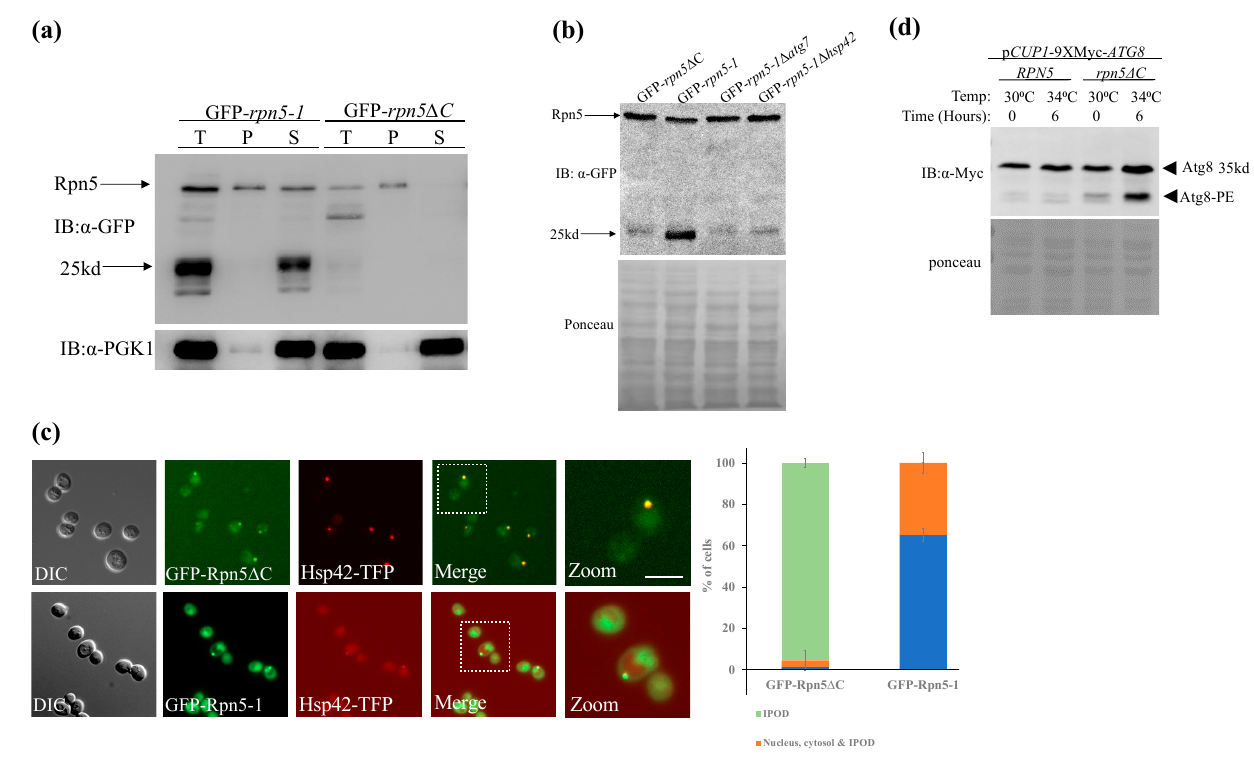
Figure 3. Dysfunctional insoluble proteasomes that accumulate in the IPOD represent an alternative pathway for proteasomes that escape proteaphagy. ( a , b ) Cells carrying the ts alleles of rpn5 Δ C, and rpn5 ‐ 1, expressed under a galactose ‐ inducible promoter ( GAL1 p) (GFP ‐ rpn5 Δ C and GFP ‐ rpn5 ‐ 1, re ‐ spectively) were grown in 2% galactose ‐ containing medium to logarithmic phase at the semi ‐ per ‐ missive temperature (34 °C), and subjected to the detergent solubility assay. ( b ) Free ‐ GFP signal of rpn5 ‐ 1 overexpressed under a GAL1 promoter (GFP ‐ rpn5 ‐ 1) is the result of autophagic cleavage. Cells carrying GFP ‐ rpn5 ‐ 1 and deleted in the control autophagic pathway were subjected to free ‐ GFP assay as described in Figure 1. GFP ‐ rpn5 Δ C was used as a negative control. ( c ) Cell described in A were visualized by differential interference contrast (DIC) microscopy. Images were taken with a 63× objective, and represent a single plane chosen from z ‐ series images extending above and below the entire cell. The GFP and mCherry channels were used to visualize the GFP, and TFP fluores ‐ cence, respectively. The distribution of GFP ‐ rpn5 Δ C and GFP ‐ rpn5 ‐ 1 signal was scored as the per ‐ centage of cells showing: (i.) Puncta colocalizing with the IPOD marker Hsp42 ‐ TFP (IPOD), (ii.) nu ‐ cleus, cytosol & IPOD (iii.) nucleus, cytosol. Error bars show the standard deviation between three independent experiments (a minimum of 50 cells in each experiment). Bars ‐ 5 μ m. ( d ) Autophagy is induced in the rpn5 Δ C mutant. Logarithmically growing wt and rpn5 Δ C cells expressing ATG8 N ‐ terminally fused to 9xMyc through a copper (CuSo4) inducible promoter (p CUP1 ‐ 9xMyc ‐ ATG8 ) were split to a medium with (+), or without ( ‐ ) CuSO 4 . Protein extracts were subjected to Western blot analysis and immunoblotted with anti ‐ Myc antibody. Myc ‐ Atg8, and Myc ‐ Atg8 conjugated to the lipid phosphatidylethanolamine (PE), are indicated by black arrows. Ponceau staining was used as the loading control.